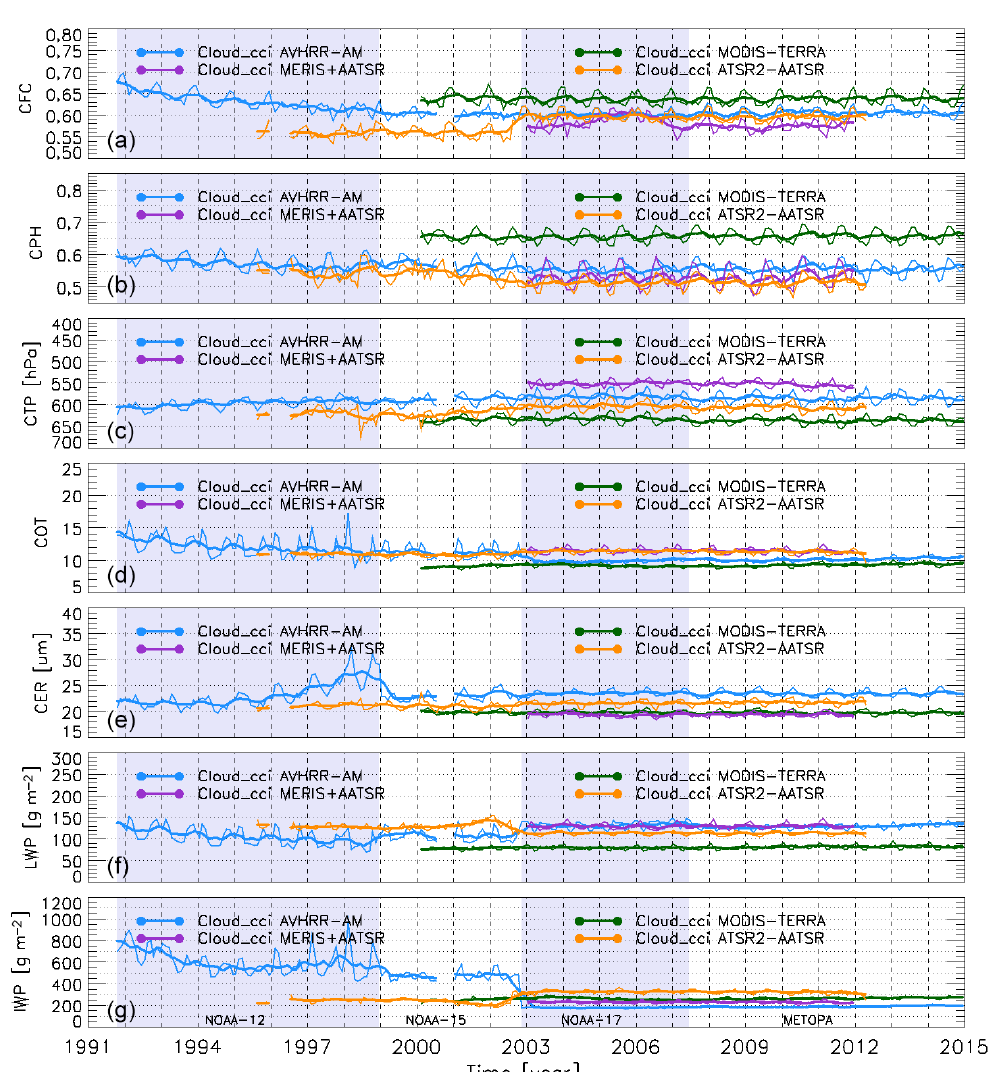
Figure 8. Time series of monthly mean cloud properties of Cloud_cci datasets, with thin lines being (from top to bottom) time series of monthly mean cloud fraction (CFC), liquid cloud fraction (CPH), cloud-top pressure (CTP), cloud optical thickness (COT), cloud effective radius (CER), liquid water path (LWP) and ice water path (IWP), overlaid with a running average (thick lines). Shown are those Cloud_cci datasets that are based on so-called morning satellites. The monthly means are calculated for 60 ◦ S–60 ◦ N (latitude-weighted). The time series shown have not been corrected for satellite drift or diurnal